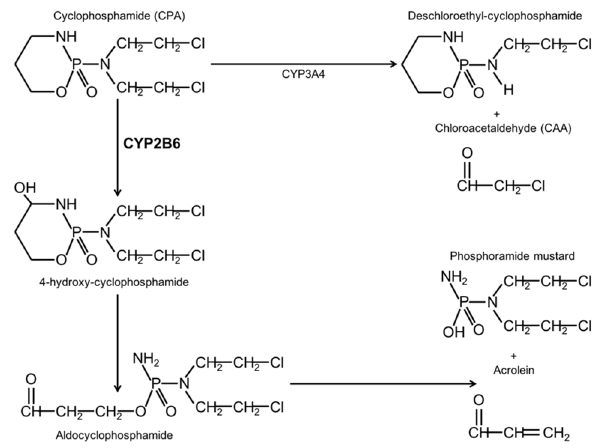
Figure 1. Role of CYP2B6 in cyclophosphamide metabolism. CPA prodrug is mainly activated by CYP2B6 by hydroxylation. The 4-hydroxy-CPA is decomposed to phosphoramide mustard, the DNA alkylating metabolite with antitumoral activity. CYP3A4 is the main enzyme responsible of the dechloroethylation of CPA and CAA formation, which have severe toxic effects.